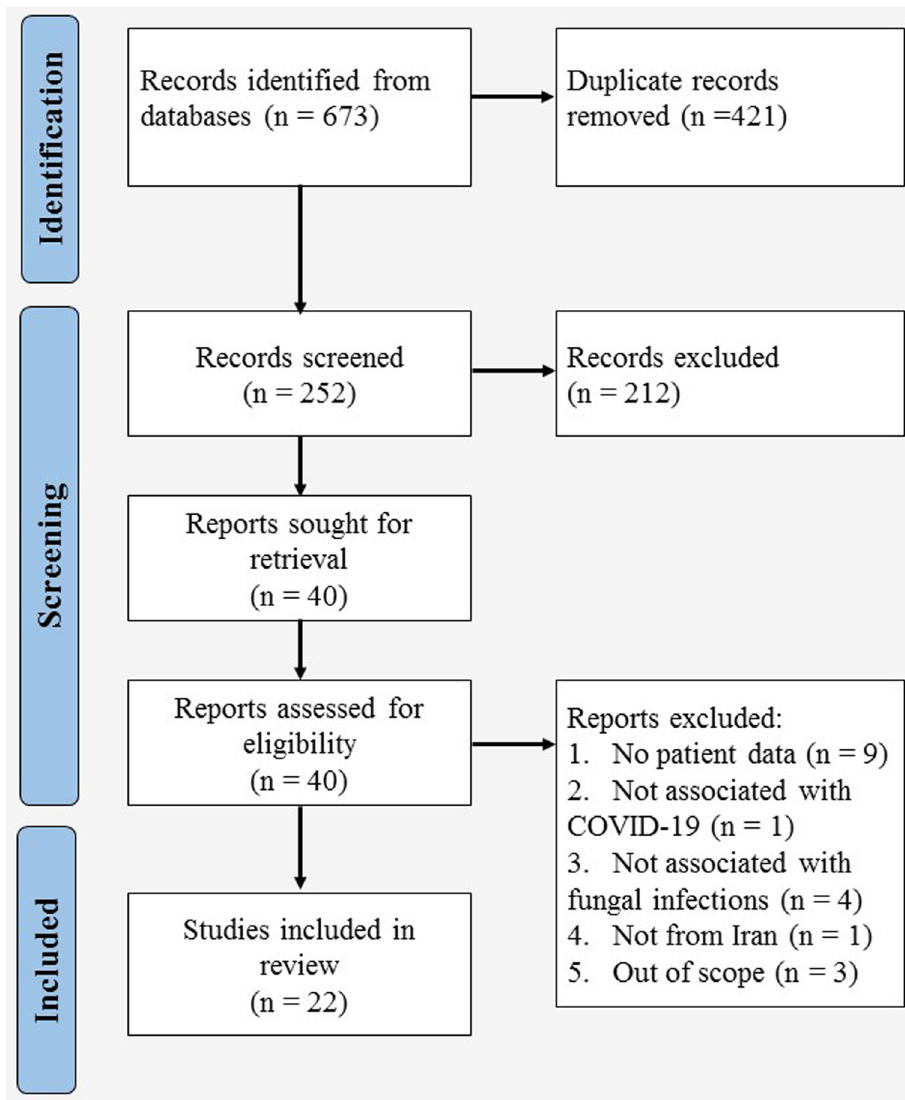
Fig 1. The PRISMA flow diagram for selection of studies reporting data on COVID-19-associated fungal infections in Iran up to November 5, 2021.